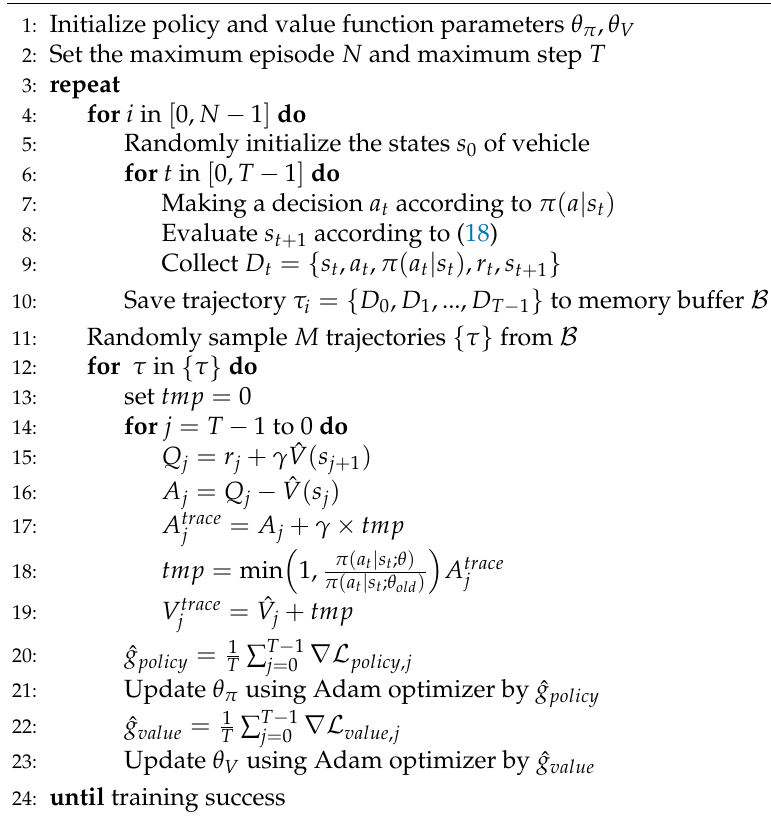
Algorithm 1 Learning